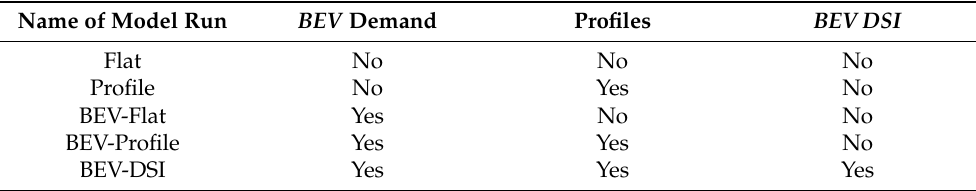
Table 6. Overview of the model runs which are used to analyze profile costs. Name of Model Run